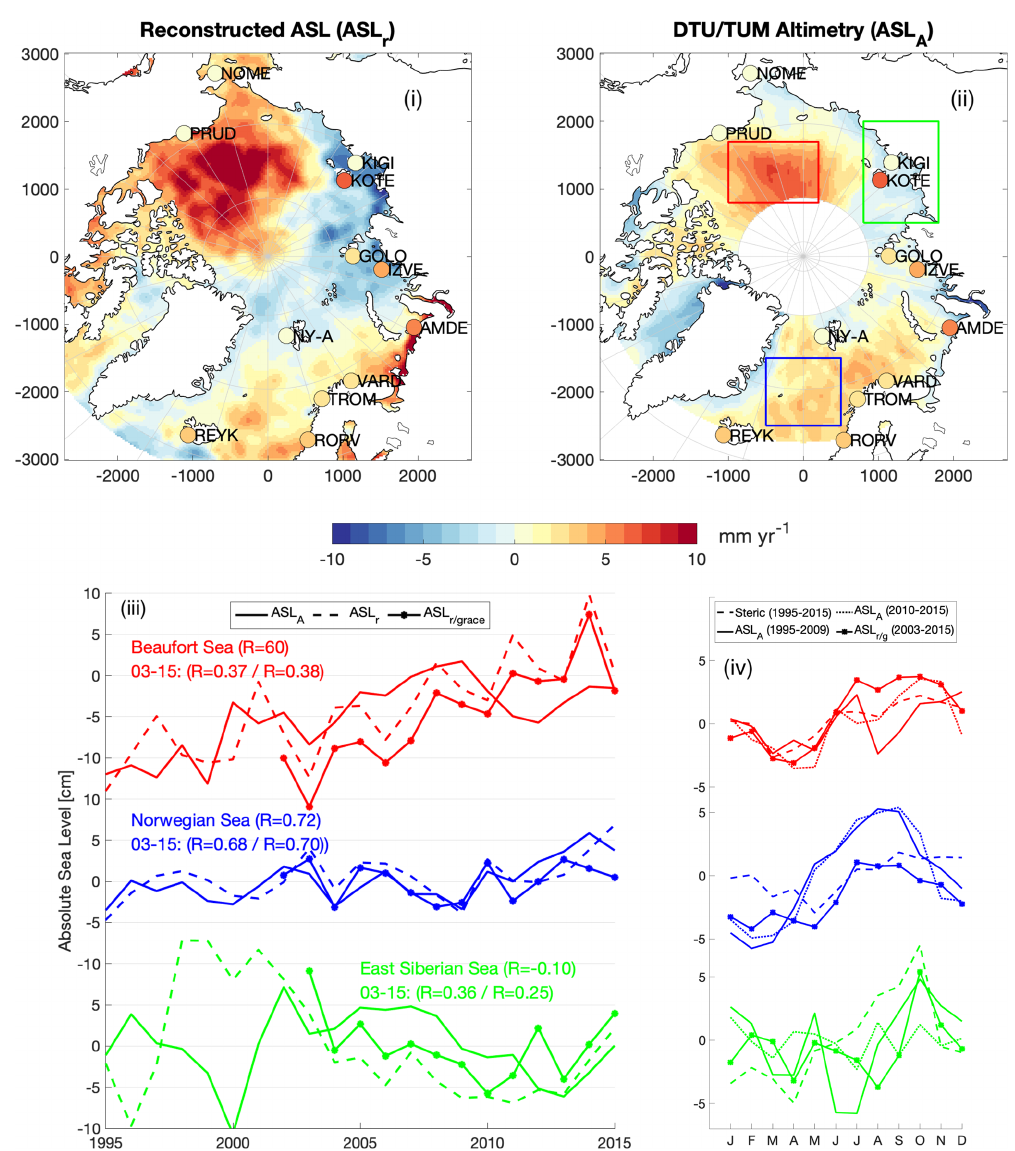
Figure 7. Absolute sea level trend of the reconstructed product ( ˙ ASL r ) (i) and from DTU/TUM altimetry ( ˙ ASL A ) (ii) from 1995 to 2015 [mmyr − 1 ]. In both maps the sea level trend of the 12 VLM-corrected tide gauges ( ˙ ASL TG ) is shown with circles. (iii) The time series of ASL A , ASL r and ASL r / grace (ASL reconstructed with GRACE – mean of the two GRACE estimates used in this study) for three selected regions: Beaufort Sea (red), Norwegian Sea (blue) and East Siberian Sea (green) (areas marked in the DTU/TUM altimetry map). The top R coefficient for each region shows the correlation between ASL A and ASL r , and beneath the R coefficient is shown between ASL A , ASL r / ASL A and ASL r / grace for 2003 to 2015. (iv) The mean seasonal cycle for two periods of ASL A (solid line: 1995–2009, dotted